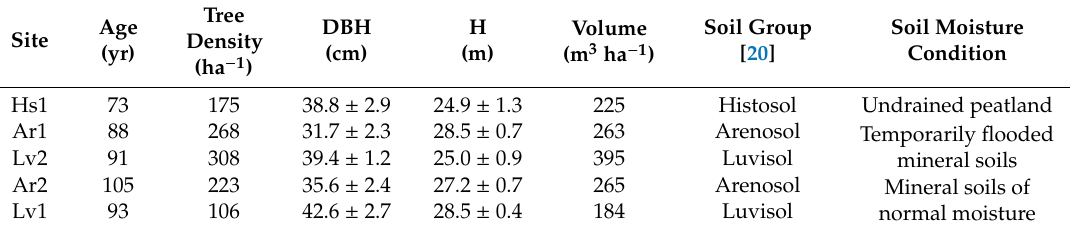
Table 1. The mean dendrometric properties of pure silver birch ( Betula pendula Roth) stands growing in di ff erent